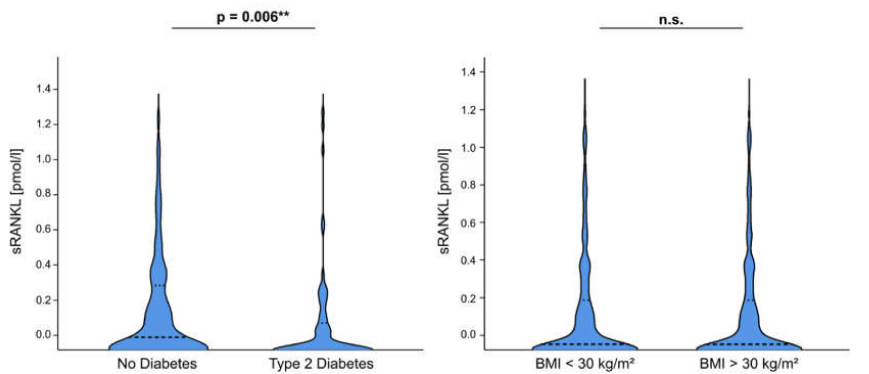
Figure 3. sRANKL serum levels are associated with type 2 diabetes. sRANKL serum concentrations were significantly decreased in patients diagnosed with type 2 diabetes but did not correlate with BMI classification (BMI < or > 30 kg/m 2 ). All data are shown as available. ** p < 0.005, n.s.: not